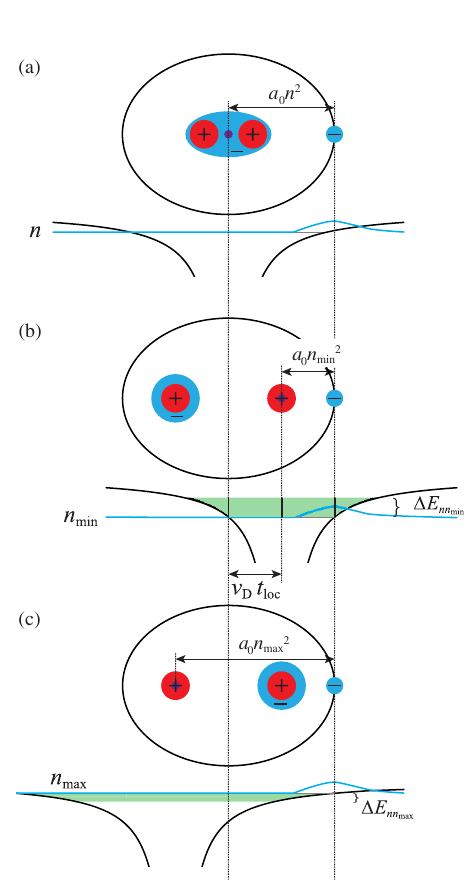
FIG. 6. Schematic representation of the effect, on a high- n Rydberg electron, of the charge localization of the dissociating D 2 þ ion core on one of the two fragments. The situations prior to charge localization, and after localization of the core charge on the fragment located closest to, and furthest away from, the “ semiclassical ” Rydberg electron, are depicted in panels (a), (b), and (c),